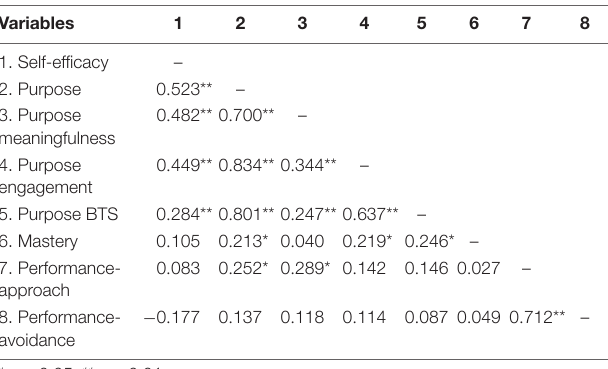
TABLE 2 | Inter-correlations among participants’ pre-test